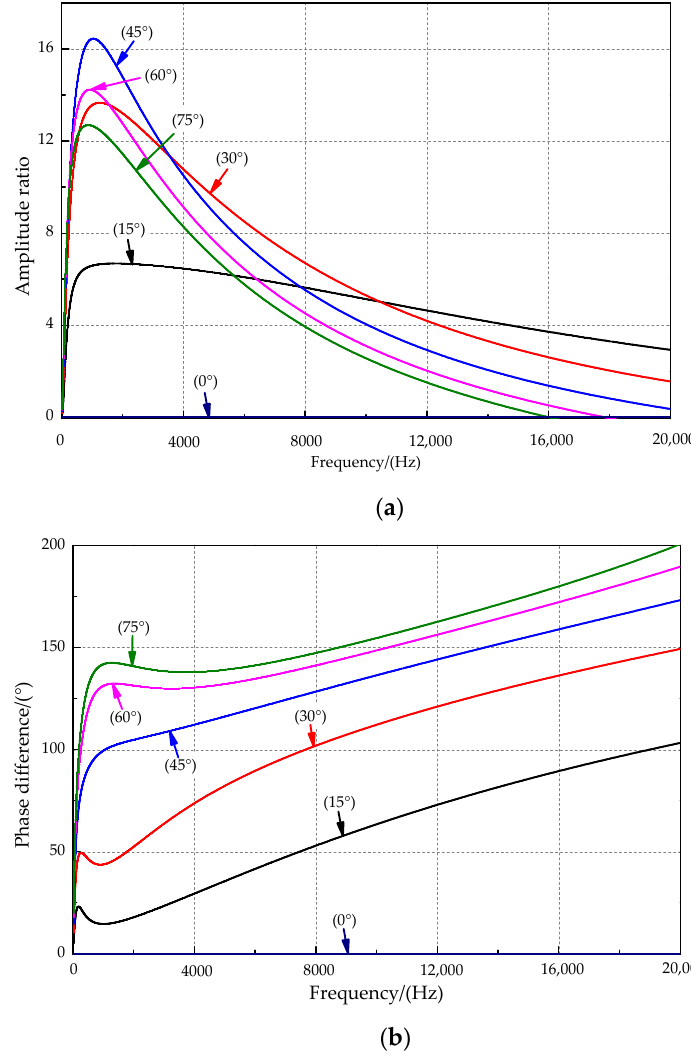
Figure 6. The relationship between key parameters and the frequency. ( a ) The amplitude ratio and the frequency. ( b ) The phase difference and the frequency.